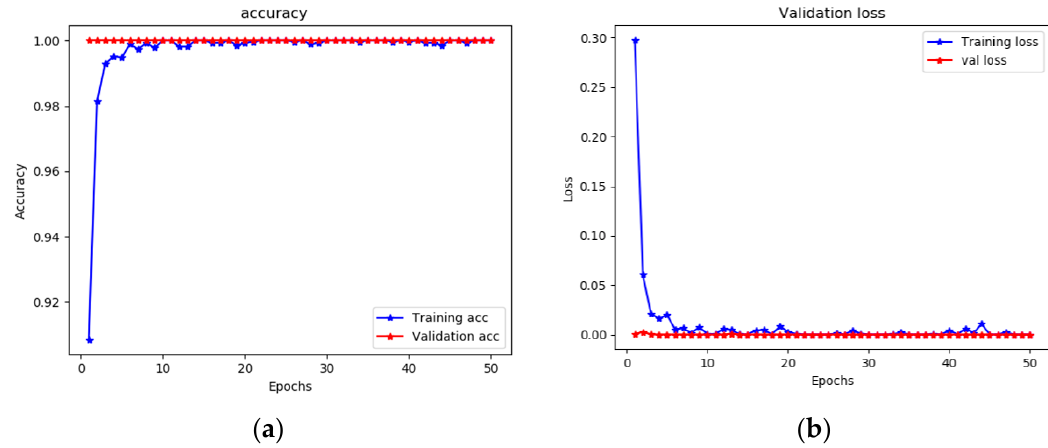
Figure 9. ResNet-50 model training results. ( a ) The accuracy of self-predicted data. ( b ) The loss function of self-predicted data.